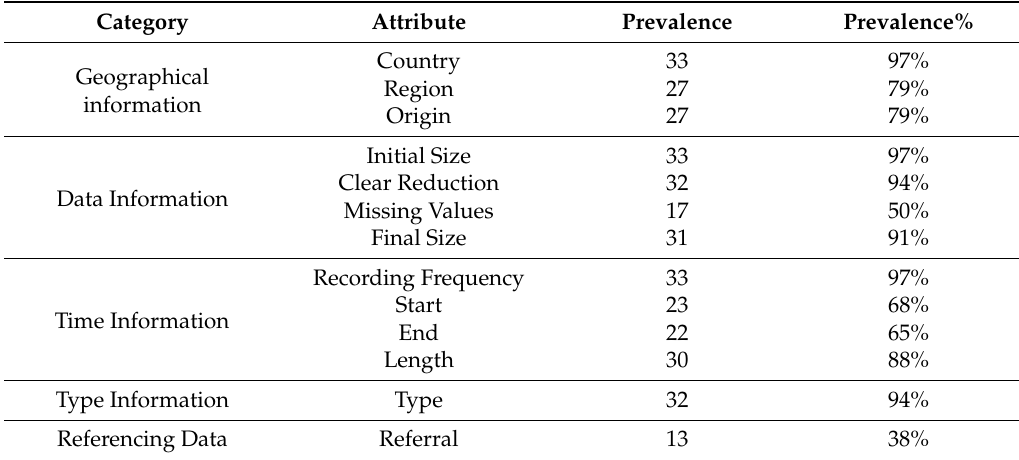
Table 4. Data Description Score comprising of 5 main categories with a total of 13 different attributes. Prevalence describes the number occurrences of the attribute in the 34 papers. Percent shows the prevalence percent of the 34 papers.